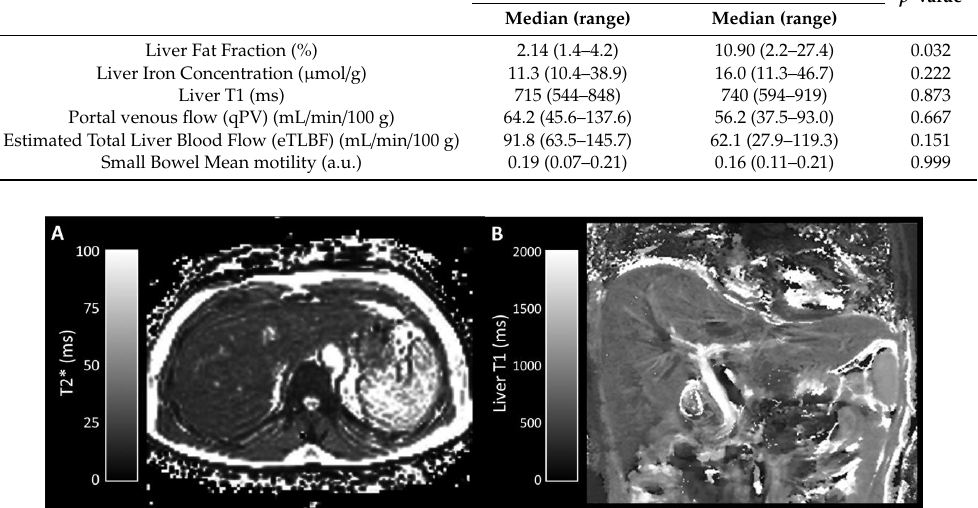
Figure 4. Parametric mapping of ( A ) liver T2* (axial) and ( B ) liver T1 (coronal). Segmental regions of interest placed ( A ) on T2* maps were converted into liver iron concentration (average 13.6 μmol/g in this example) and ( B ) on T1 maps (average 848 ms in this example).